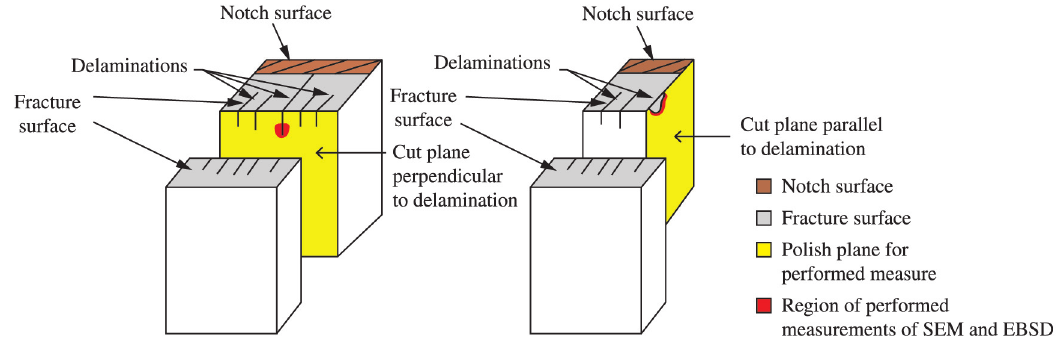
Figure 3. Schematic representation of removed samples for performing EBSD: a) cut plane of the perpendicular direction of fracture propagation; b) cut plane in the parallel region to the direction of fracture propagation.